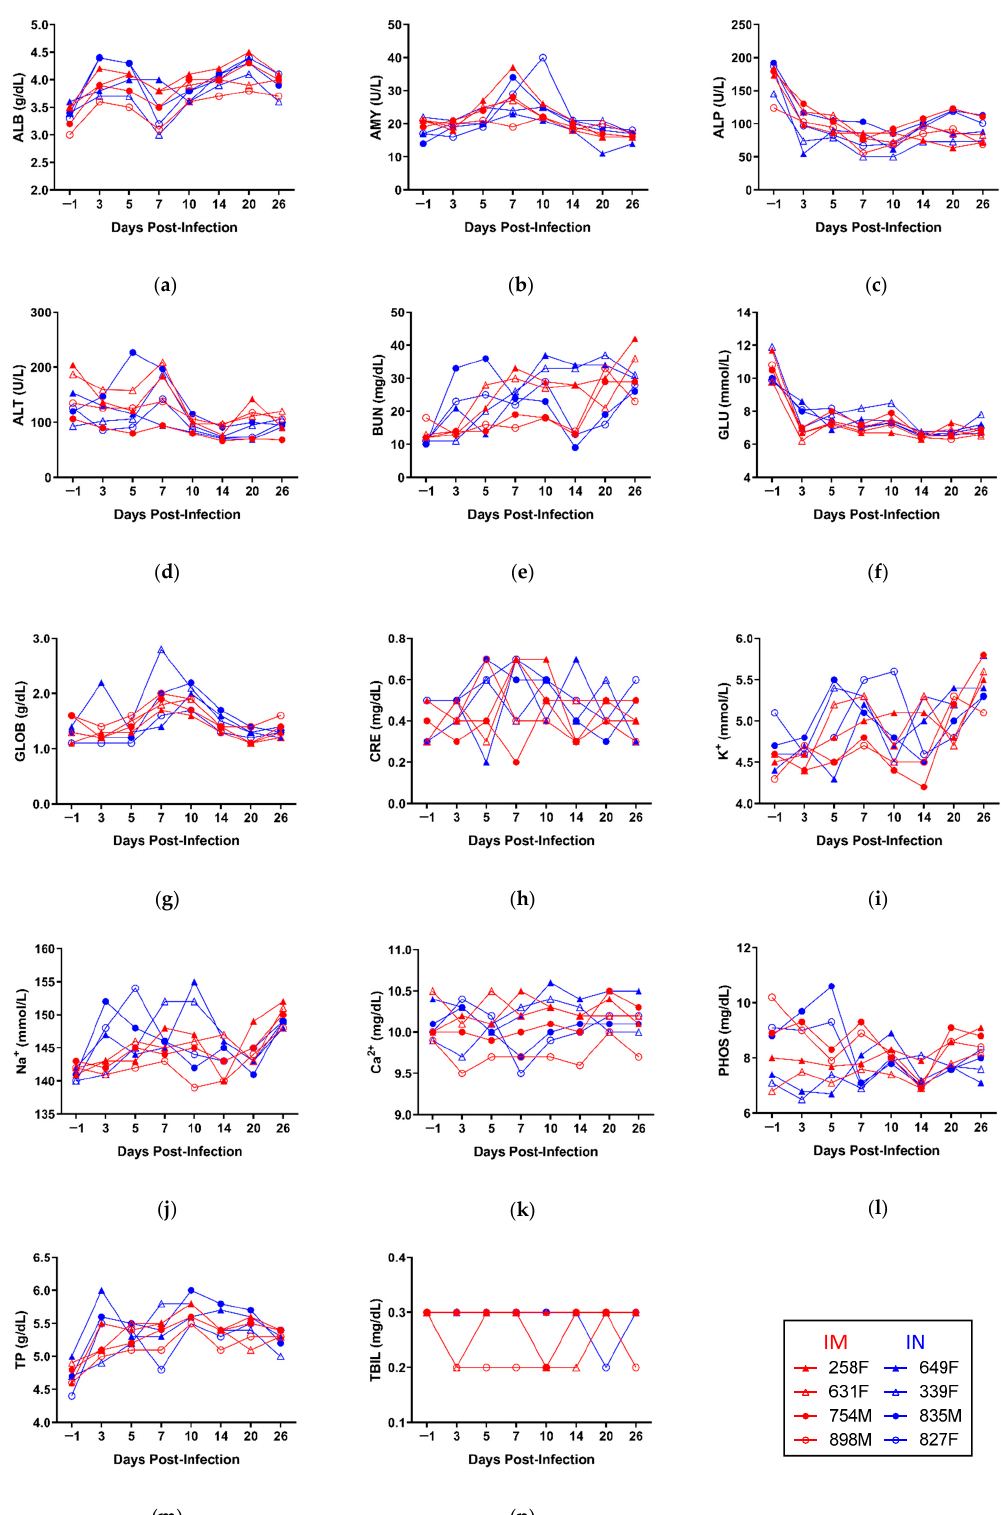
Figure 3. Biochemical parameters of TAFV-infected ferrets. Whole blood was collected from each animal on days − 1, 3, 5, 7, 10, 14, 20, and 26 post-infection, and the concentrations of the following analytes measured: ( a ) albumin (ALB); ( b ) amylase (AMY); ( c ) alkaline phosphatase (ALP); ( d ) alanine aminotransferase (ALT); ( e ) blood urea nitrogen (BUN); ( f ) blood glucose (GLU); ( g ) globulin (GLOB); ( h ) creatinine (CRE); ( i ) potassium (K + ); ( j ) sodium (Na + ); ( k ) calcium (Ca 2+ ); ( l ) phosphorus (PHOS); ( m ) total protein (TP); ( n ) total bilirubin (TBIL). Individual animal IDs and sex (F/M) are indicated in the key. IM, intramuscular inoculation; IN, intranasal inoculation.